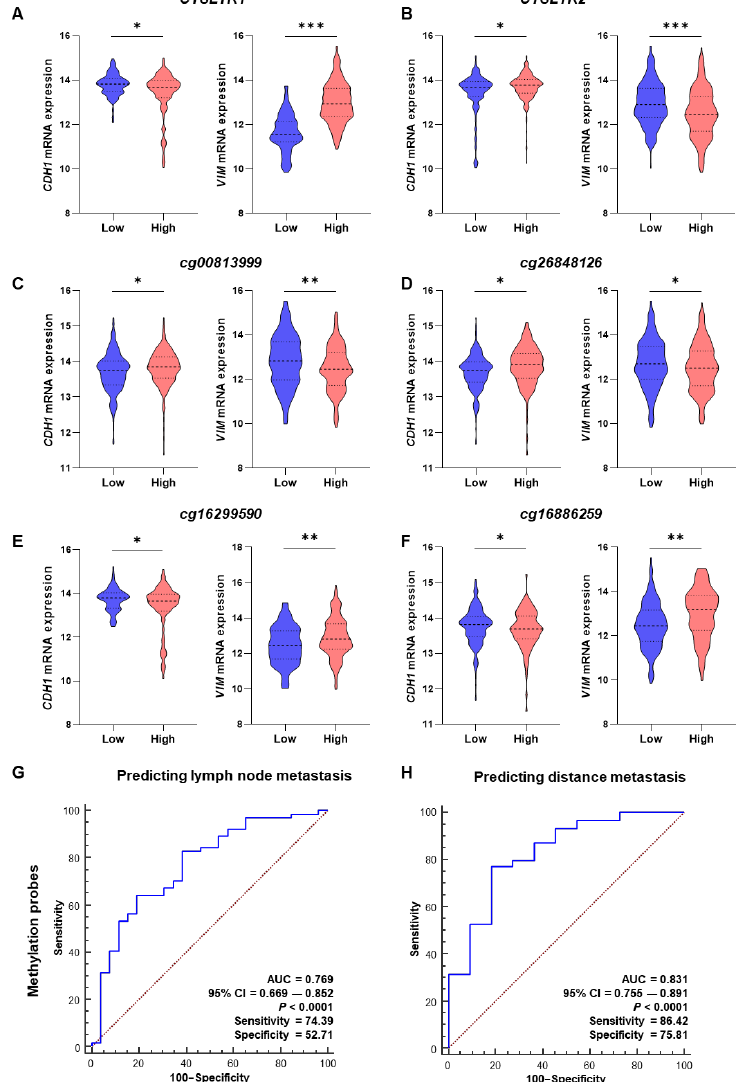
Figure 3. Correlation of EMT marker ( CDH1 and VIM ) expression and CYSLTR1 and CYSLTR2 gene expression and their CpG probes in the TCGA-COADREAD cohort. ( A ) Correlation between CDH1 and VIM gene expression with high and low CYSLTR1 gene expression. ( B ) Correlation between CDH1 and VIM gene expression with high and low CYSLTR2 gene expression. ( C – F ) Correlation between CDH1 and VIM gene expression with high and low M values for the CpG probes of CYSLTR1 (cg00813999 and cg26848126) and CYSLTR2 (cg16299590 and cg16886259) genes. ROC–AUC curve for the prediction of lymph node metastasis ( G ) and distant metastasis ( H ) using the M values for CpG probes of CYSLTR1 and CYSLTR2 genes. * p < 0.05; ** p < 0.01; *** p <